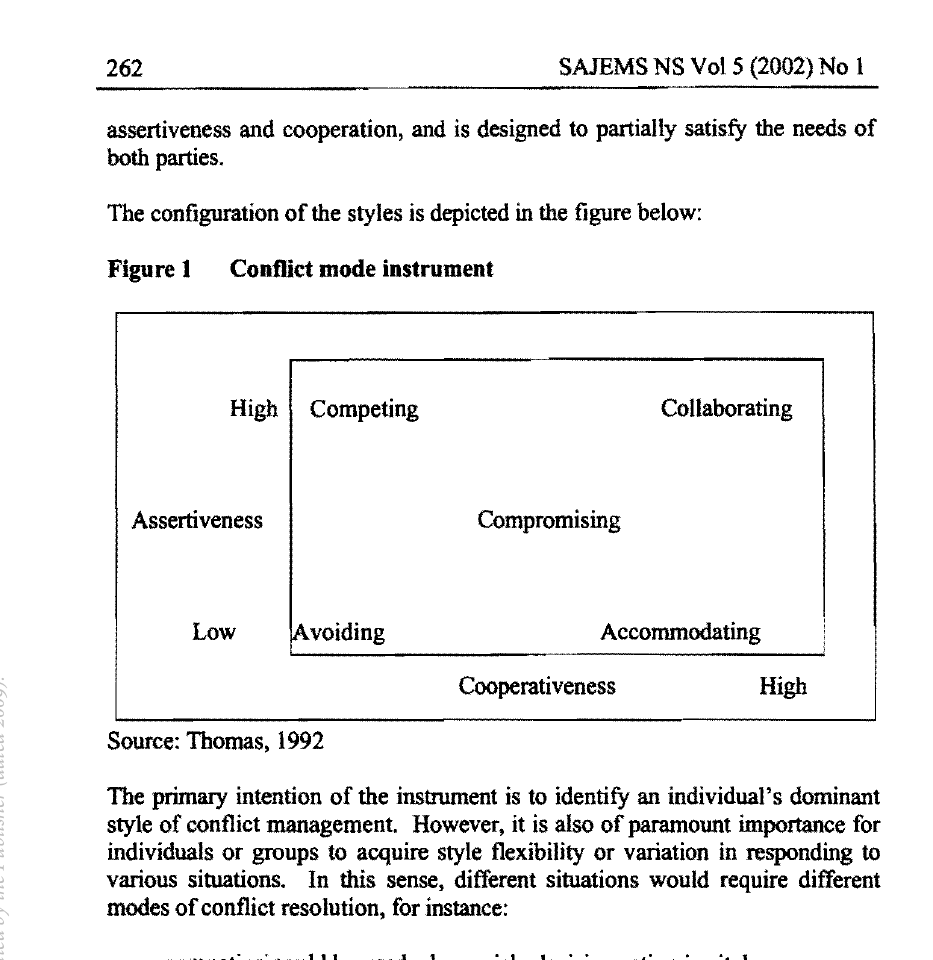
Conflict mode instrument